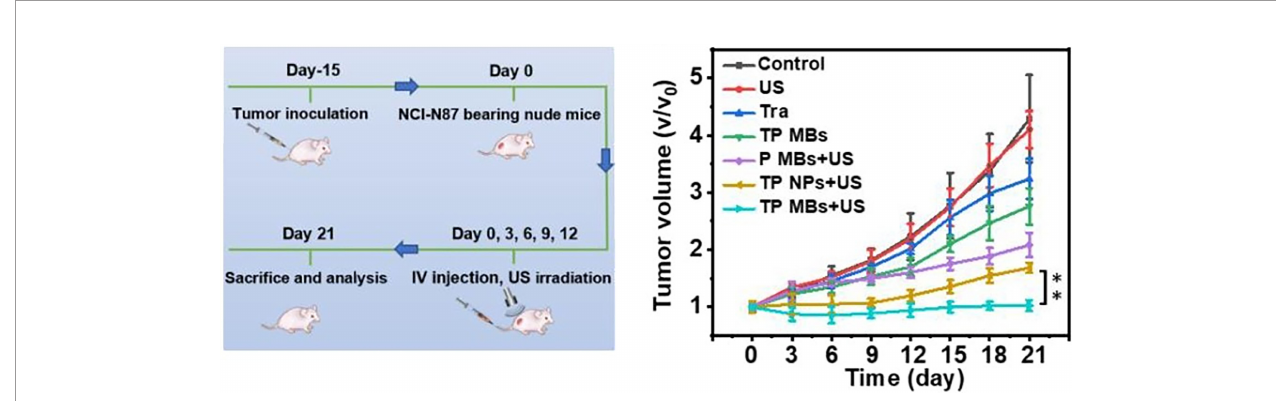
FIGURE 4 | Ultrasound microbubbles mediated sonosensitizer and trastuzumab (TP MBs) treatment signi fi cantly inhibited the proliferation of tumor cells. The TP MBs + US group showed the best therapeutic effect with almost no tumor volume change for 21 days. Reprinted (adapted) with permission from ref (20). copyright © 2022 American Chemical Society.